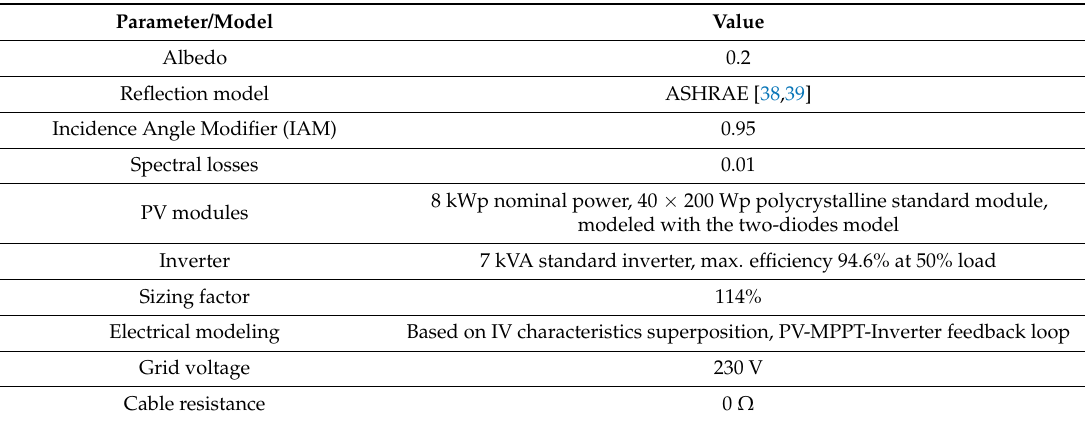
Table 3. Other parameters and models used in the model chain for the PV system